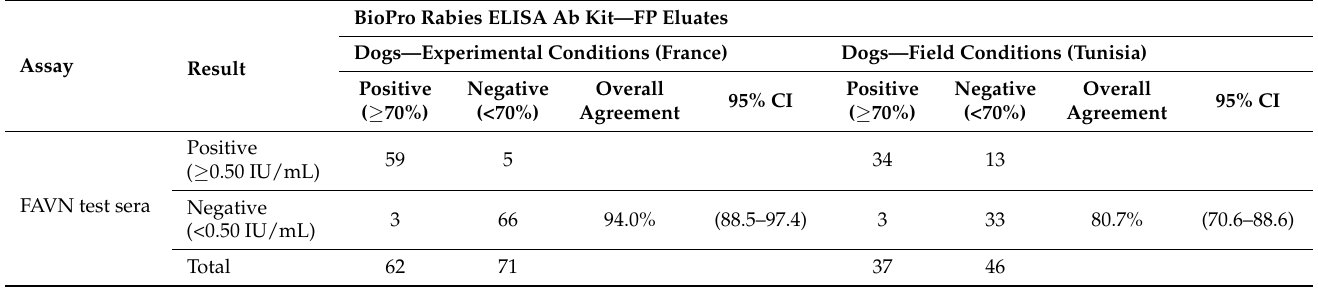
Table 1. FP eluates titrated with the BioPro ELISA kit versus sera titrated with FAVN test.